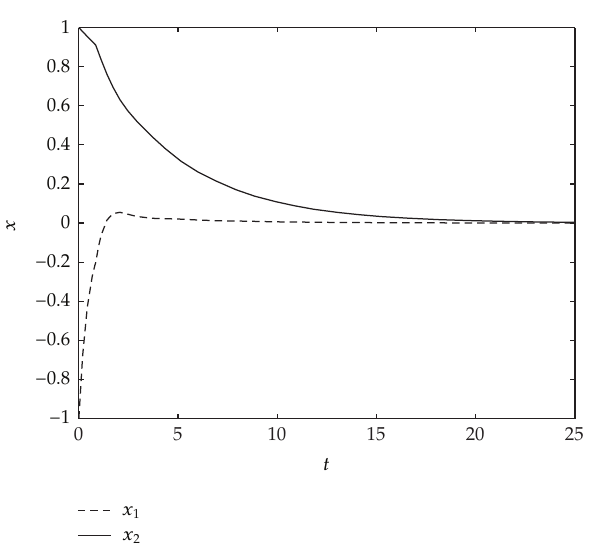
Figure 3: The trajectory of solution of system i (cid:8) 1 under the feedback controller (cid:6) 4.4 (cid:7) .